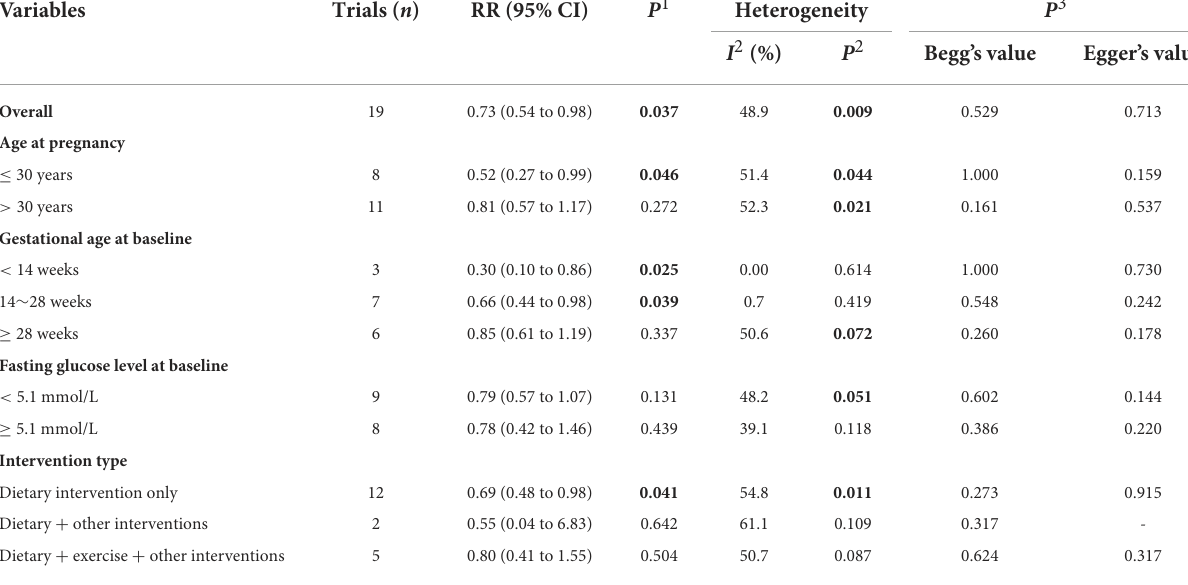
TABLE 2 Results of subgroup analysis and publication bias stratified by study